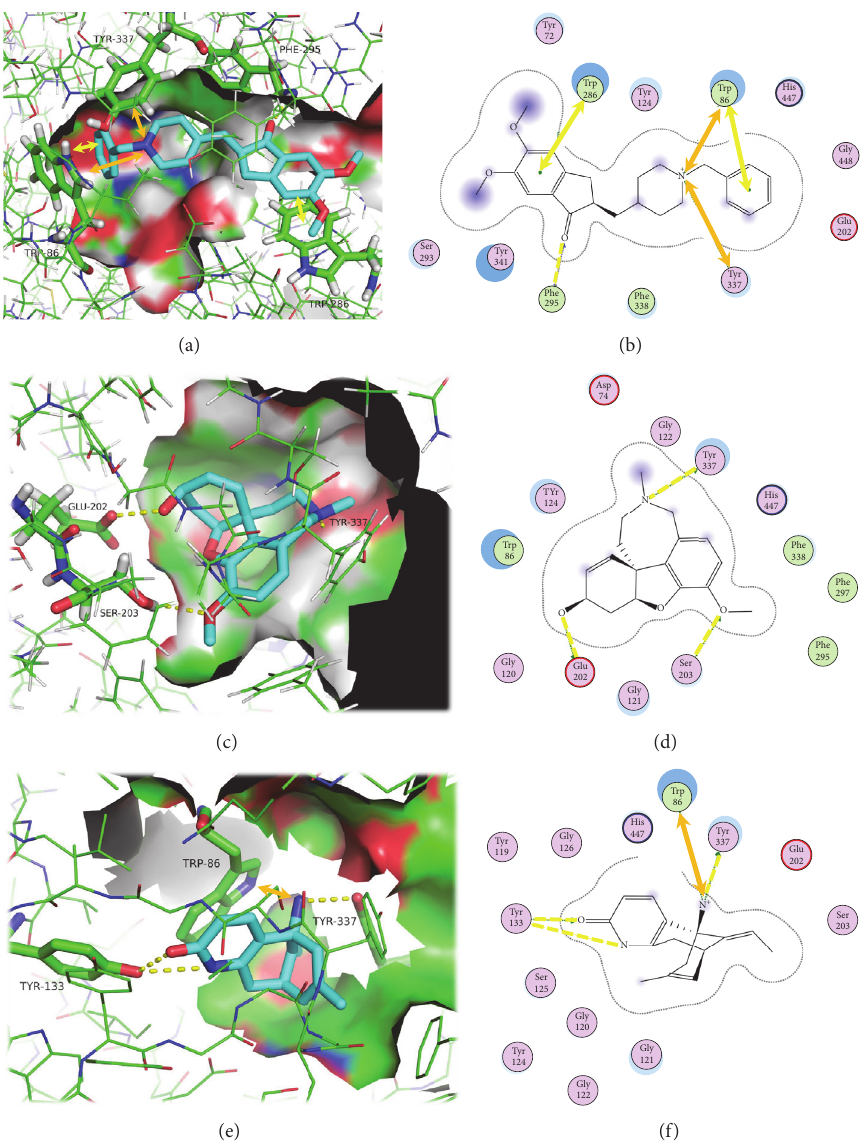
Figure 3: AChE active site (surface) bound to crystallographic donepezil (pdb ID: 4EY7) (a), galantamine (pdb ID: 4EY6) (c), and huperzine A (pdb ID: 4EY5) (e) (blue sticks). Residues involved in hydrogen interactions (yellow broken line), 𝜋 stacking interactions (yellow double arrow), and 𝜋 -cation interactions (orange double arrow) are displayed using a stick model. AChE carbon, oxygen, nitrogen, and hydrogen are represented in green, red, blue, and grey, respectively. 2D depiction view of crystallographic donepezil (b), galantamine (d), and huperzine A (f) in AChE active site. Hydrogen and 𝜋 stacking are represented with the same color scheme. Receptor residues that are close to the ligand, but whose interactions with the ligand are weak or diffuse, such as collective hydrophobic or electrostatic interactions, are also represented (all the ones that have no indication for hydrogen-bonding). Solvent accessible surface area of the ligand is plotted directly onto the atoms in the form of a blue smudge. Solvent accessible surface area for the receptor residues is plotted as a blue halo.